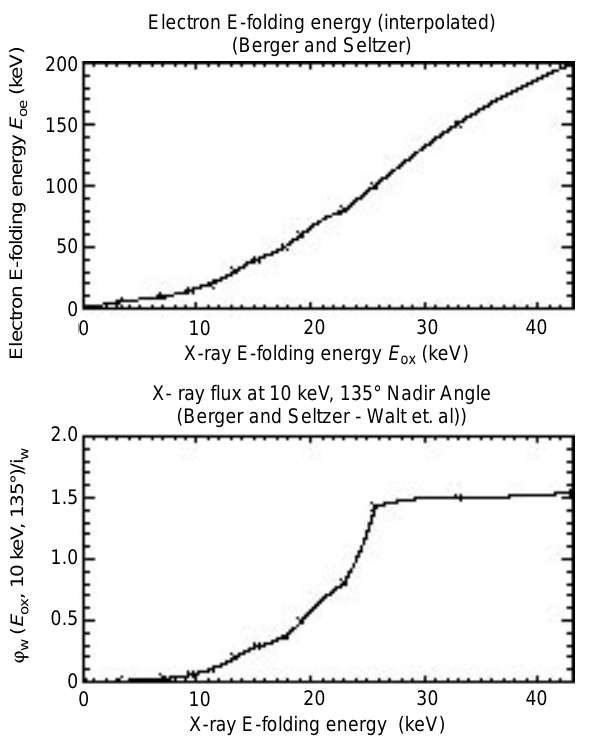
Fig. 9. Upper panel, Crosses : electron e-folding energies versus X-ray e-folding energies as calculated from X-ray spectra given by Berger and Seltzer, shown in Fig. 5. Solid line : interpolation and extrapo- lation for E o x (cid:136) 0–43 keV giving E o e up to 200 keV, using a third- order polynomial approximation. Lower panel: the X-rays produced at 10 keV as a function of X-ray e-folding energies. Crosses are the values deduced from Berger and Seltzer (1974) and Walt et al . (1979). Solid Line is the third order polynomial interpolation and